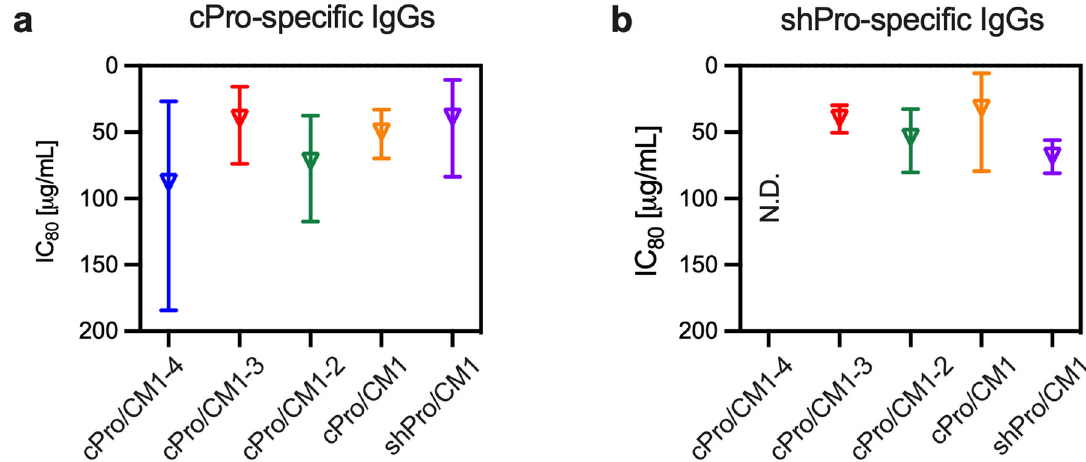
Fig. 4 cPro- and shPro-speci fi c antibodies are functional. a cPro-speci fi c IgG from each original total IgG was tested in three independent assays at fi ve different concentrations, then the IC 80 (open reverse triangle) and 95%CI (error bars) were calculated. The y -axis is reversed as Fig. 1b. b shPro-speci fi c IgGs were also tested in three SMFAs at fi ve different concentrations, and IC 80 (and the error range) values were calculated. N.D.: not determined, because the amount of shPro-speci fi c IgG from anti-cPro/CM1-4 total IgG was too limited to determine IC 80